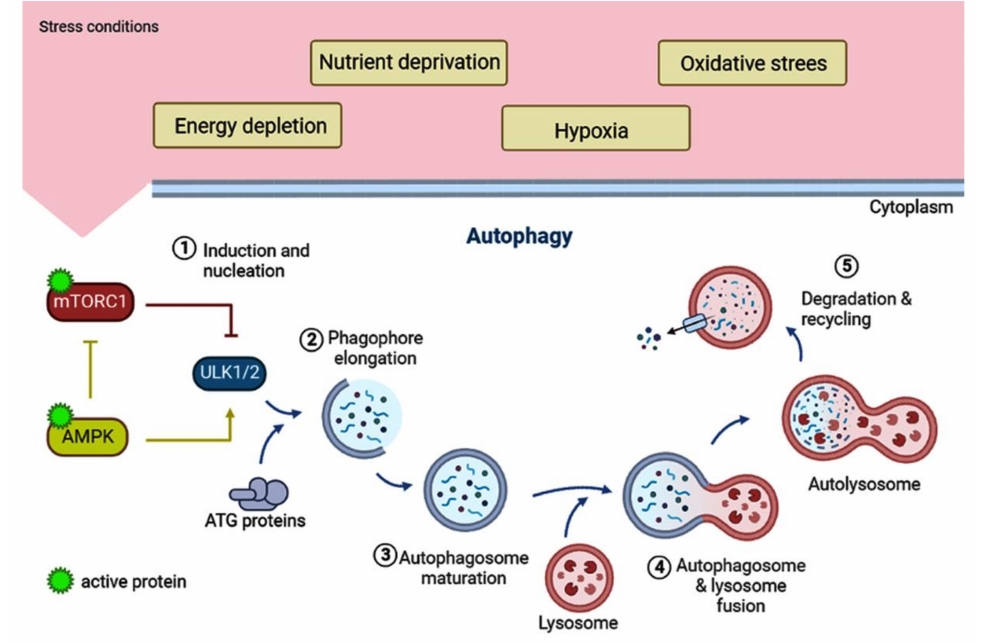
Figure 2. The autophagic process and its regulation. Autophagy is active at low levels in all cells maintaining cytoplasmic homeostasis. However, under different cellular stress conditions such as energy depletion, nutrient deprivation, hypoxia or oxidative stress, autophagy can be induced to higher levels, allowing the cells to survive. The intracellular regulation of autophagy involves the two main kinases sensing growth factors, amino acids, glucose and energy status: AMPK and mTORC1. Under nutrient-rich conditions, mTORC1 phosphorylates and inactivates the ULK1/2 complex, preventing autophagy. Upon nutrient starvation, mTORC1 is inactivated, allowing the induction of autophagy. Alternatively, energy depletion or hypoxia alter the ratio of AMP and ATP, activating AMPK. Active AMPK can inactivate mTORC1 promoting autophagy (1). AMPK can also directly phosphorylate and activate the ULK1/2 complex and induce autophagy (1). After activation of the ULK1/2 complex, other protein complexes necessary to consolidate nucleation are recruited. Several ATG proteins participate from phagophore elongation (2) to autophagosome maturation (3). Next, the autophagosomes fuse with lysosomes (4) for the degradation of their contents. Finally, the autophagolysosomal content is released into the cytoplasm for recycling